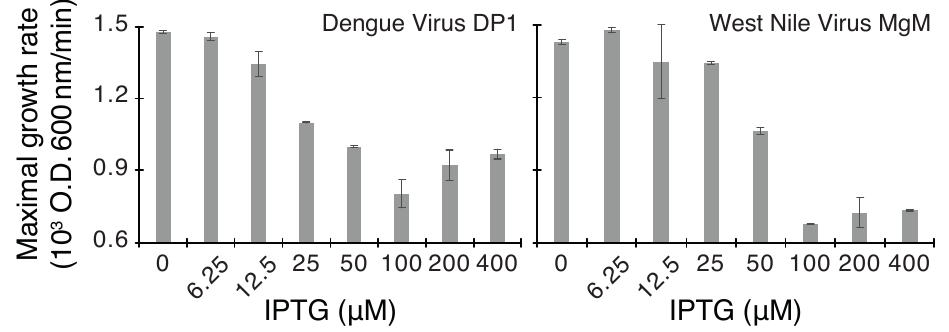
Figure 1. Negative assay of Dengue Virus DP1 and West Nile Virus MgM viroporins. Maximal growth rates of DH10B bacteria expressing each viroporin are depicted as a function of the inducer concentration (IPTG).